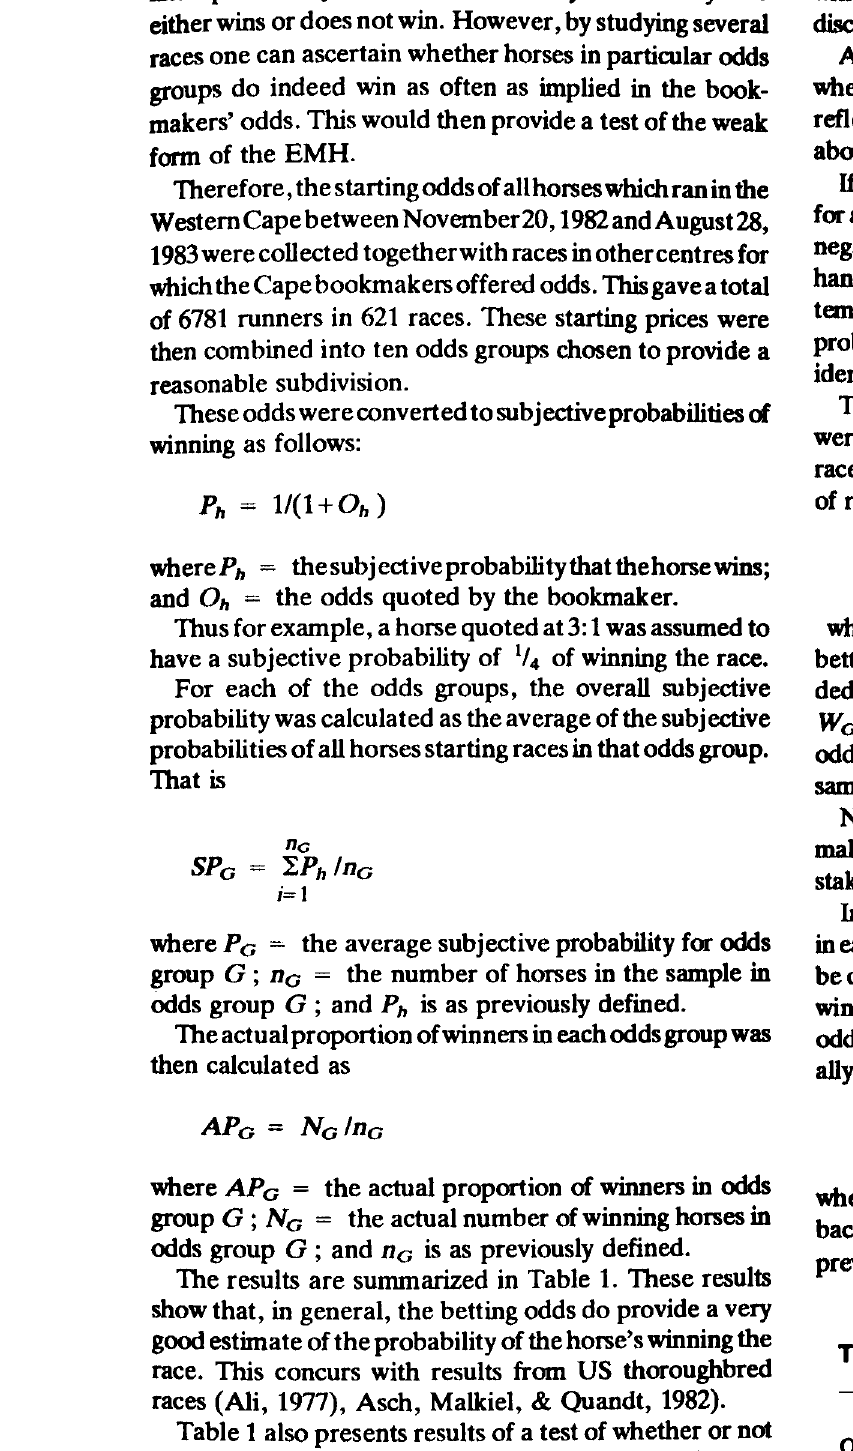
Table 1 Subjective and actual probabilities of winning Number